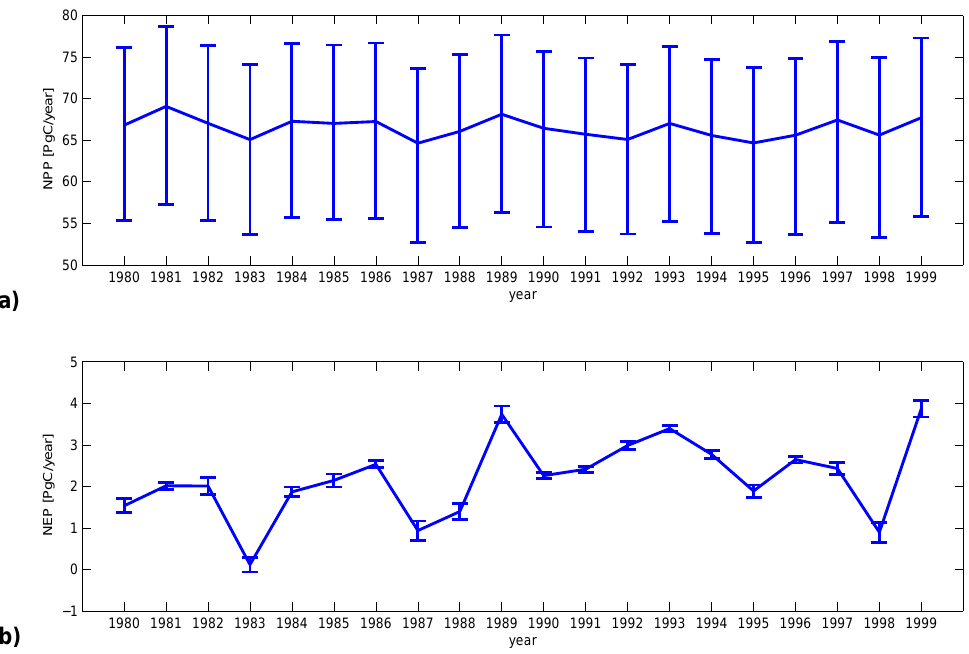
Fig. 2. Time series of (a) the global mean net primary productivity (NPP) and (b) the global mean net ecosystem productivity (NEP). For (a) the median and error bars are calculated from the 170 NPP fields for each year, which are then used as inputs for CCDAS. For (b) the median and error bars are based on the final NEP PDF for each year. Error bars represent the lower and upper percentiles equivalent to one standard deviation (i.e. 15.9th percentile and 84.1th percentile, respectively).